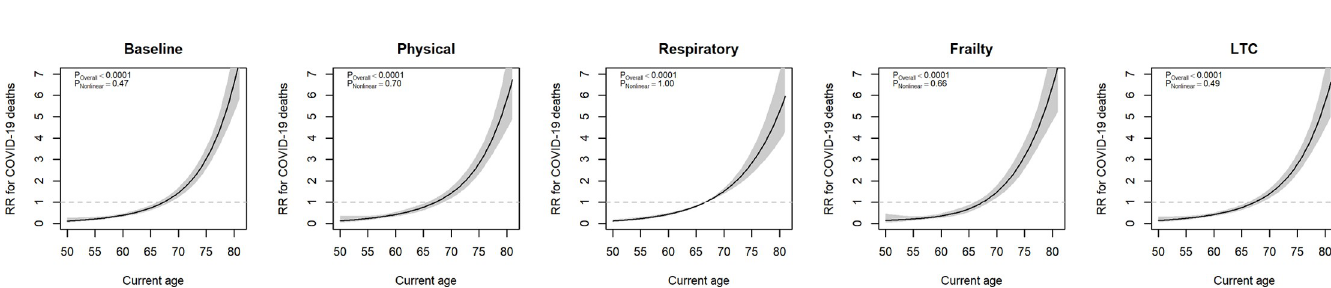
Fig 1. Association of age with COVID-19 mortality by adjustment schemes. Model 1 (Baseline): Sex, ethnicity, deprivation, duration of follow-up, smoking; Model 2 (Physical): Baseline + BMI, SBP; Model 3 (Respiratory): Baseline + FEV 1 , FEV1/FVC; Model 4 (Frailty): Baseline + frailty stages; Model 5 (LTC): Baseline + number of LTCs; BMI body mass index; SBP systolic blood pressure; FEV forced expiratory volume; FVC forced vital capacity; LTC long-term conditions.